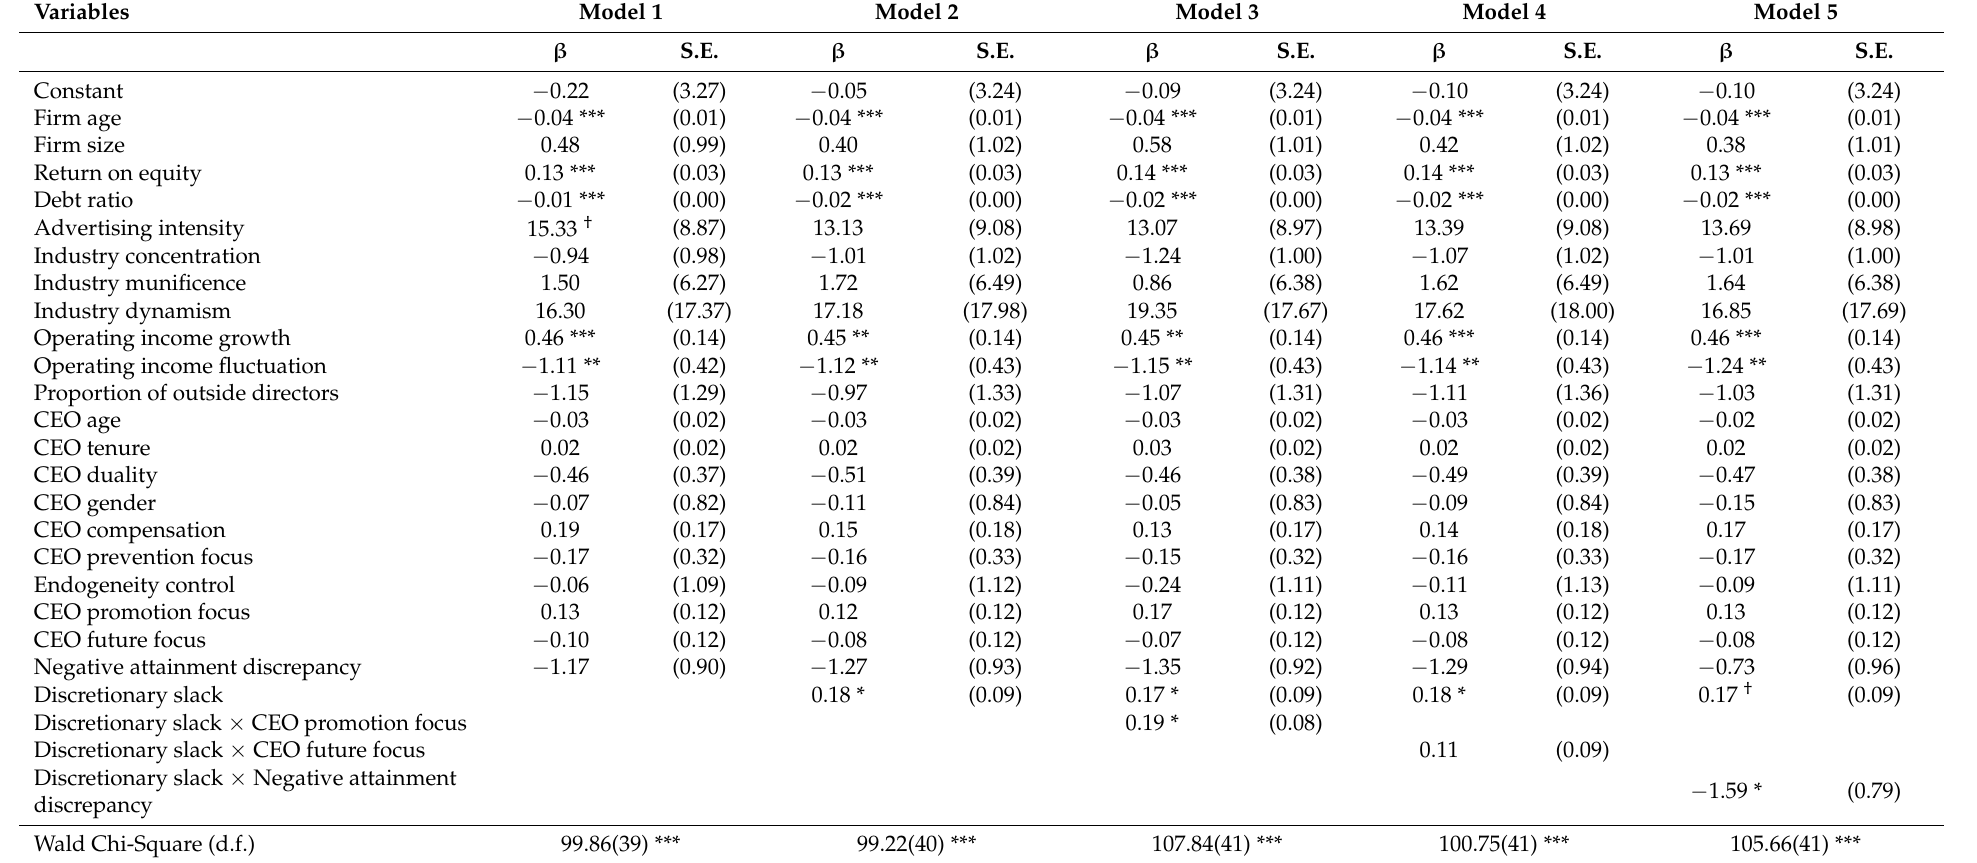
Table 2. GEE Regression Analysis: Slack, CEO Psychological Traits, and R&D